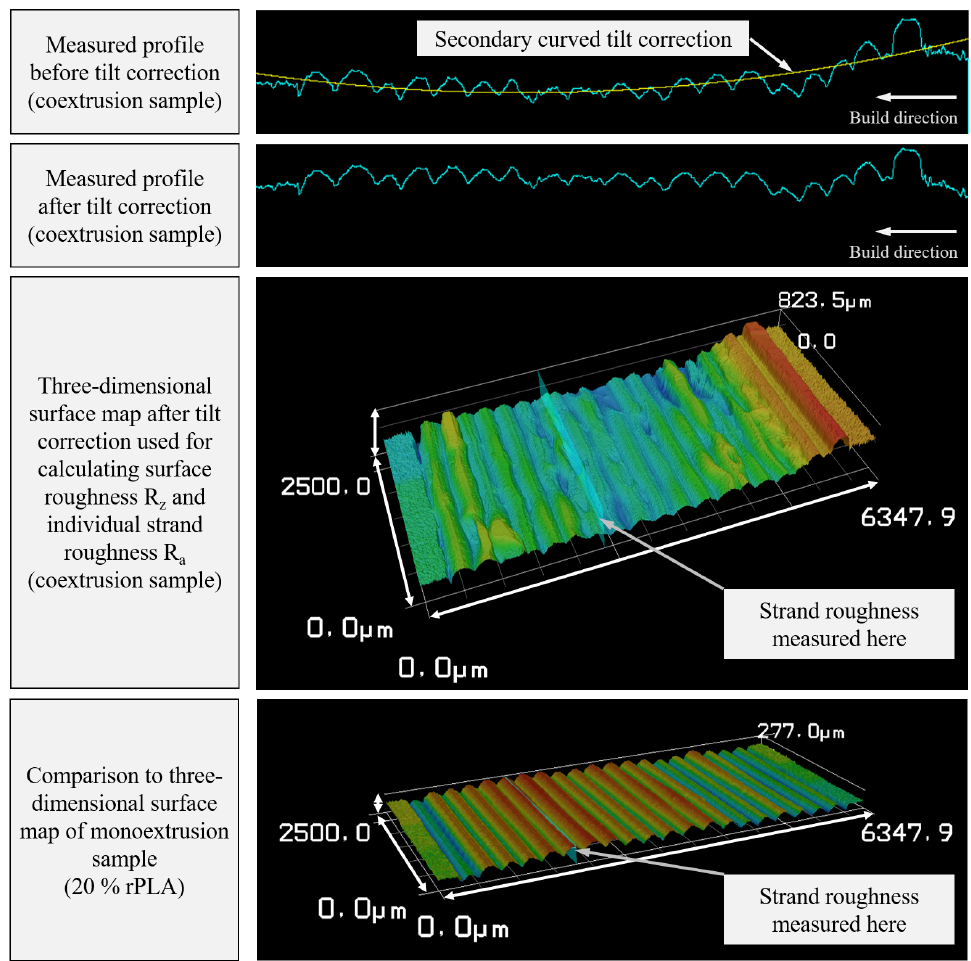
Figure 10. Surface tilt correction and three-dimensional surface map exemplified for the LSM measurement of a sample manufactured from coextruded filament. Every peak represents one individual